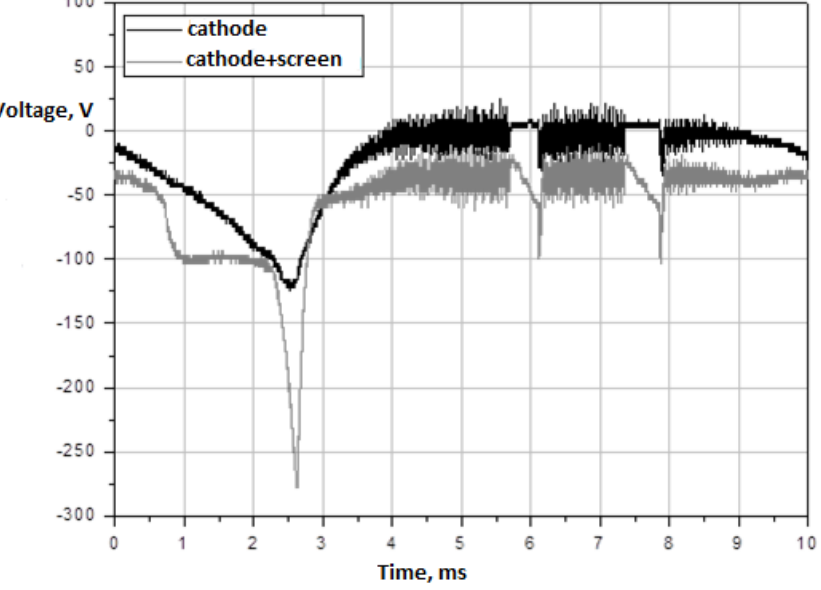
Figure 14. Comparison of the voltage waveforms at the screened sample (bottom) and the unscreened sample